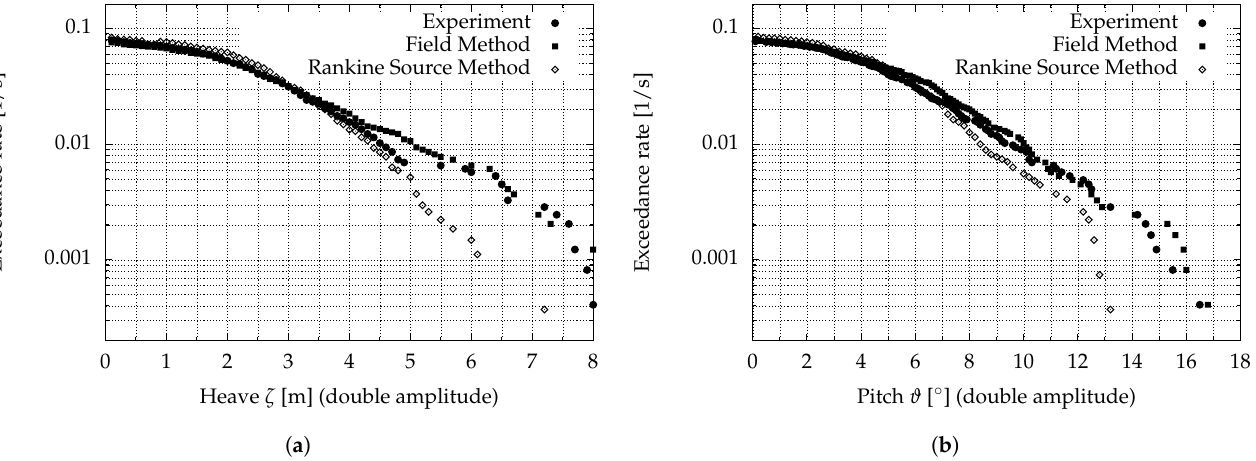
Figure 24. Chemical tanker: short-term statistics of ( a ) heave and ( b ) pitch